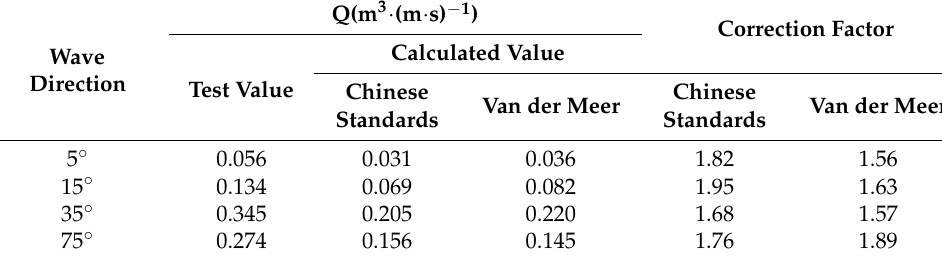
Table 3. Wave overtopping at the transition of the breakwater. Wave